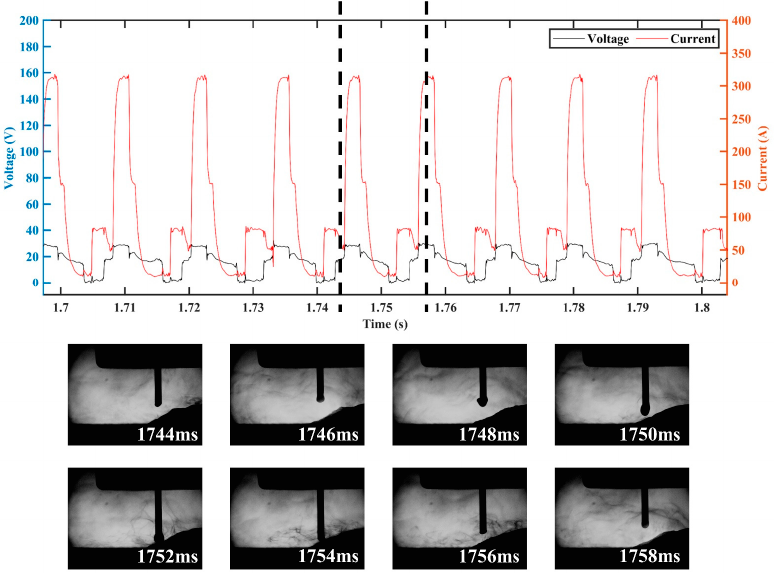
Figure 13. Electrical waveforms and droplet transfer process with the optimum CMT characteristic parameters.